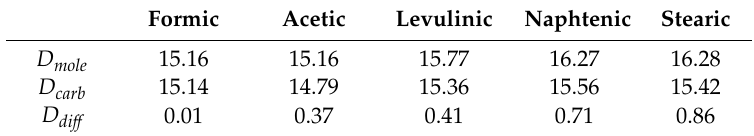
Table 1. The distances of centroids of acid molecules and carboxyl groups form the surface (Å). Formic Acetic